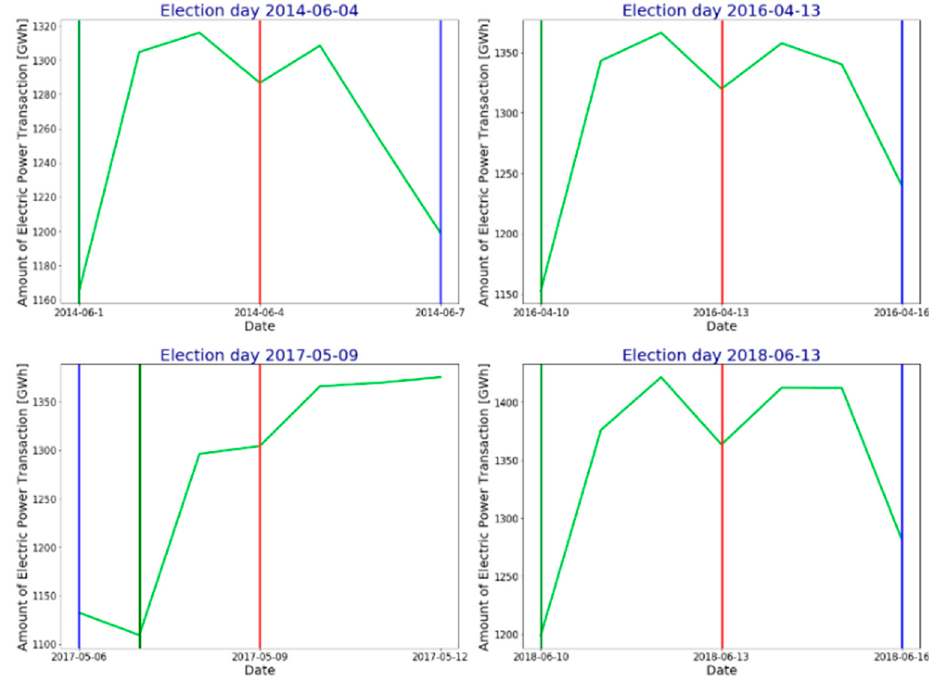
Figure 8. Election Days in South Korea during 2014–2018.